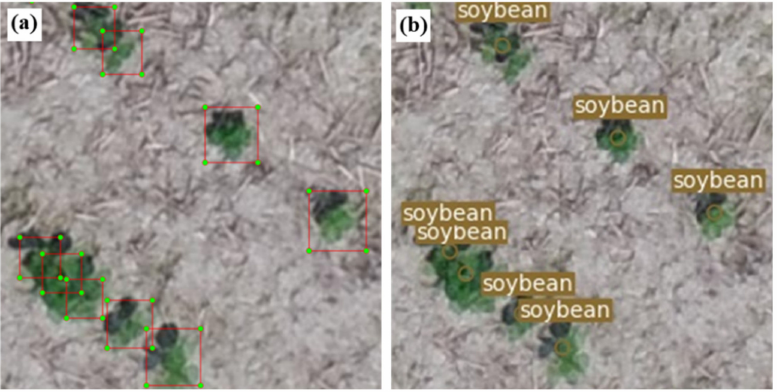
Figure 3. ( a ) Example of the annotation process of established soybean plants using LabelImg; ( b ) the established soybean plants detected by the YOLOv3